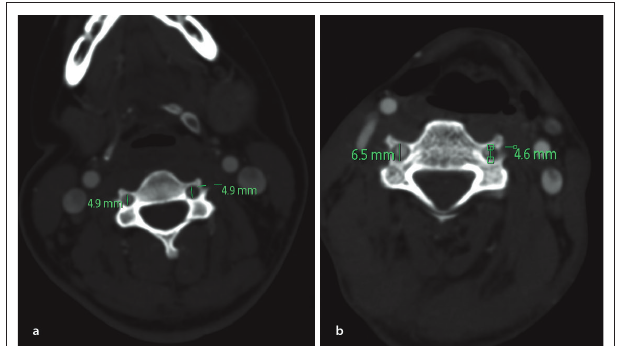
Fig. 1. Axial CTA of the vertebral arteries. In (a) the AP diameter of the transverse foraminae is equal. The left vertebral artery is much smaller than the right due to post-traumatic spasm. In (b) the AP diameter of the left transverse foramen is much smaller than the right. The left vertebral artery is proportionately smaller. This indicates a hypoplastic left vertebral artery.